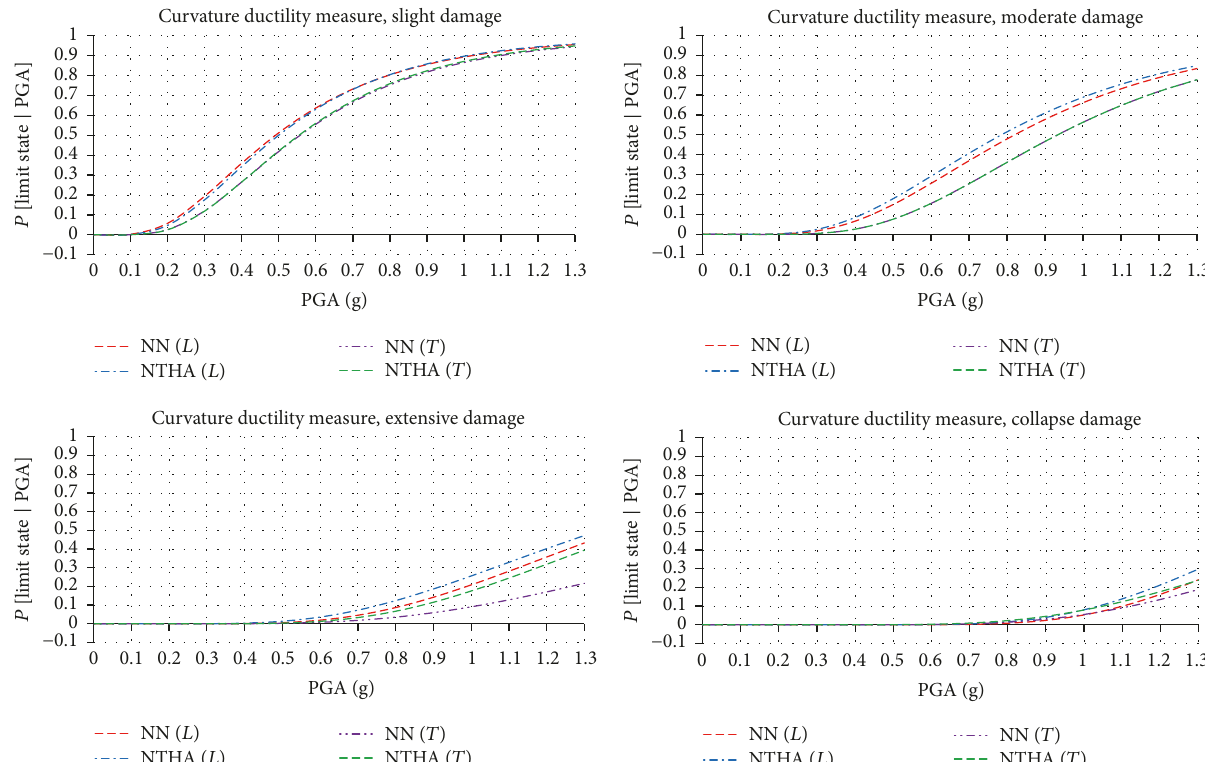
Figure 13: Comparison of the column fragility curves by NN (Approach 1) and NTHA methods.